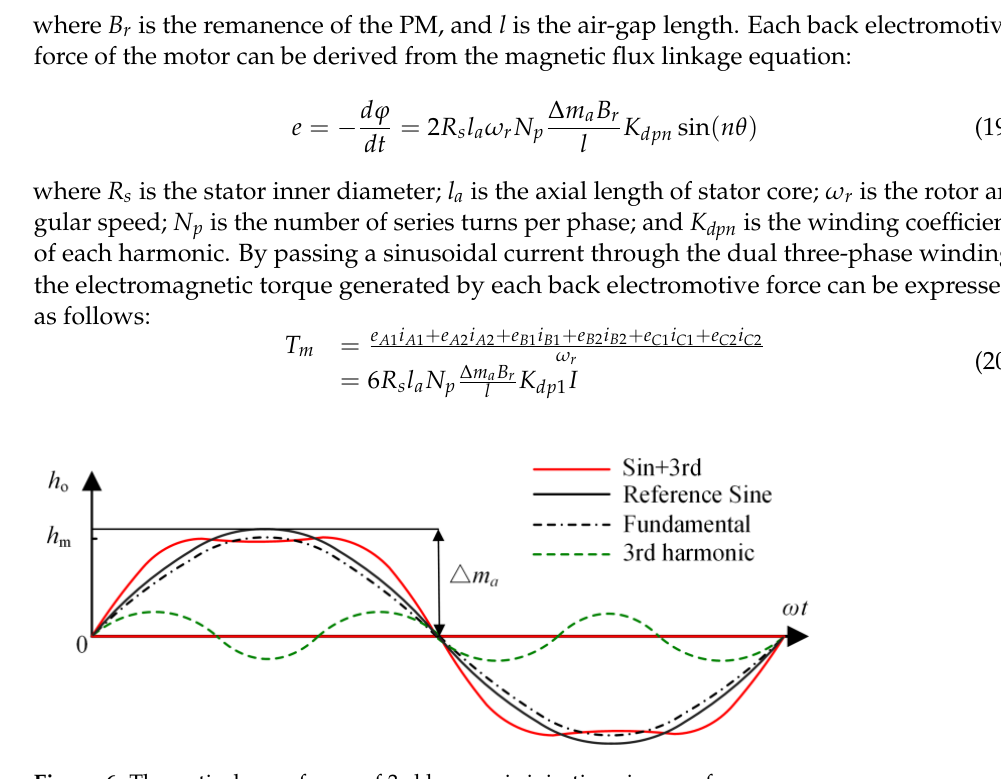
Figure 6. Theoretical waveforms of 3rd harmonic injecting sin waveform. After the third harmonic is injected into the sinusoidal pole, in order to solve for the harmonic injection amount a at the maximum PM thickness, the differential Equation